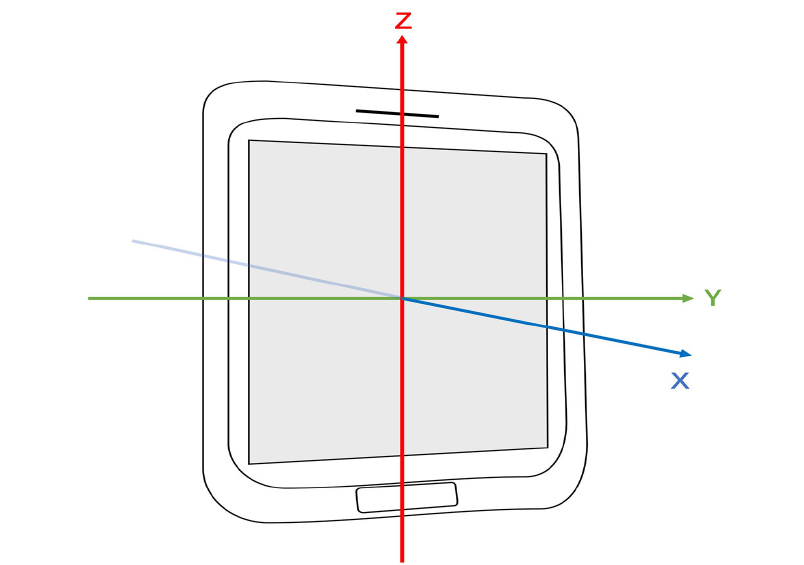
Figure 11. The coordinate system used by the Android